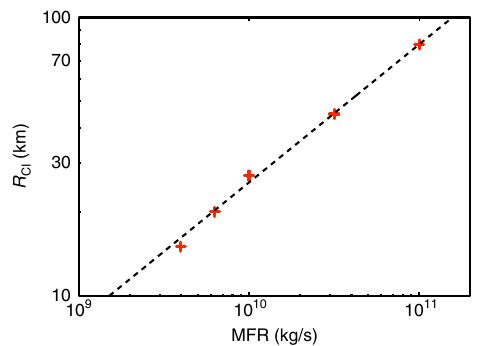
Fig. 2 Co-ignimbrite plume radius as function of MFR. Cross denotes values estimated from the 3D simulations and the line the empirical relationship given by R CI (cid:1) a (cid:3) MFR b with a ffi 2 : 8 (cid:3) 10 (cid:4) 4 kmkg (cid:4) b s b and b ffi 0 : 5. Note that the model simulates a dusty-gas mixture, whereas the pyroclastic fl ows from such super-eruptions can be formed of concentrated dispersions, which depend on imperfect coupling between gas and particles 10